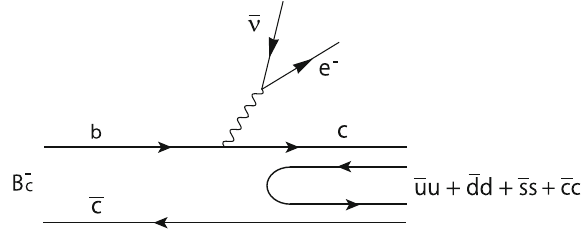
Fig. 2 Dominant mechanism for the hadronization into two mesons of the c ¯ c state after the weak